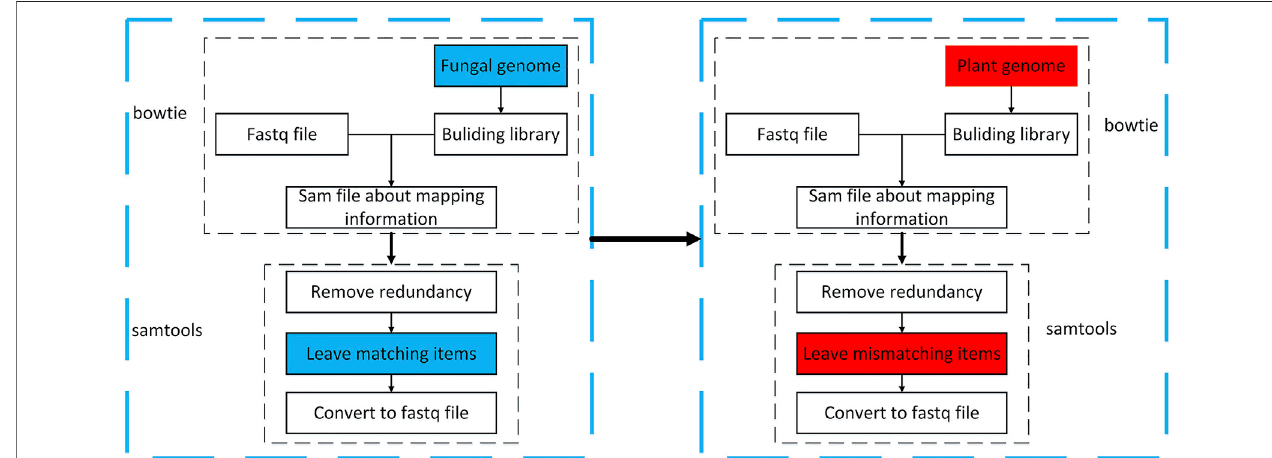
FIGURE3 | Flow chart of sRNA sequence mapping to genome.